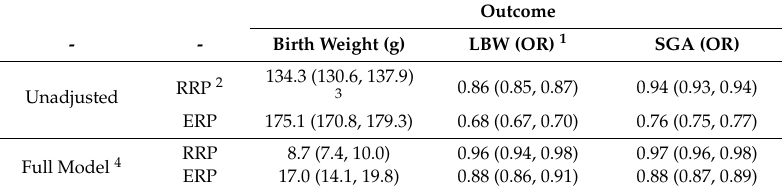
Table 2. Associations between an Interquartile Range Increase in Census Tract Racial Residential Polarization (RRP) or Economic Residential Polarization (ERP) and Birth Weight Outcomes.